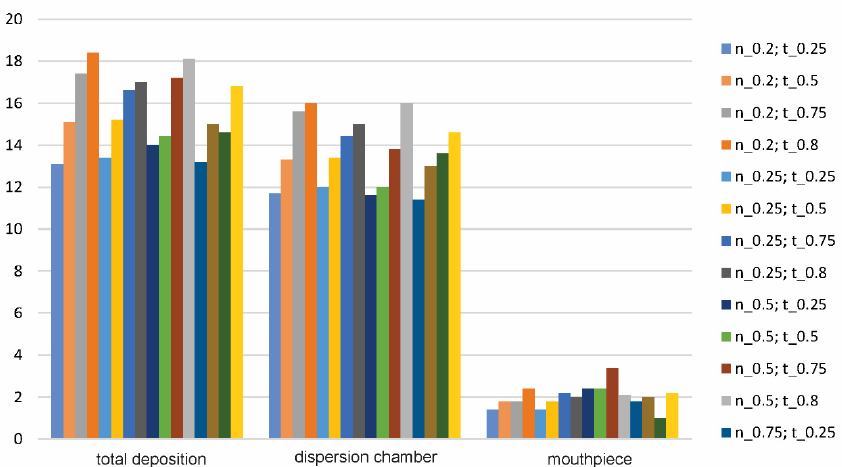
Figure 7. Percentage (%) of deposited particles for different variations of the tangential and normal COR values.